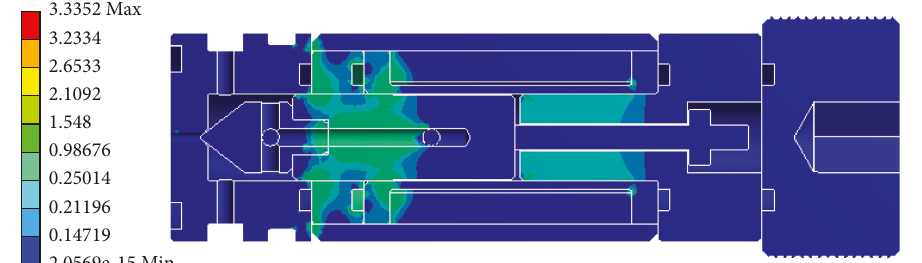
Figure 7: Total heat flux distribution.